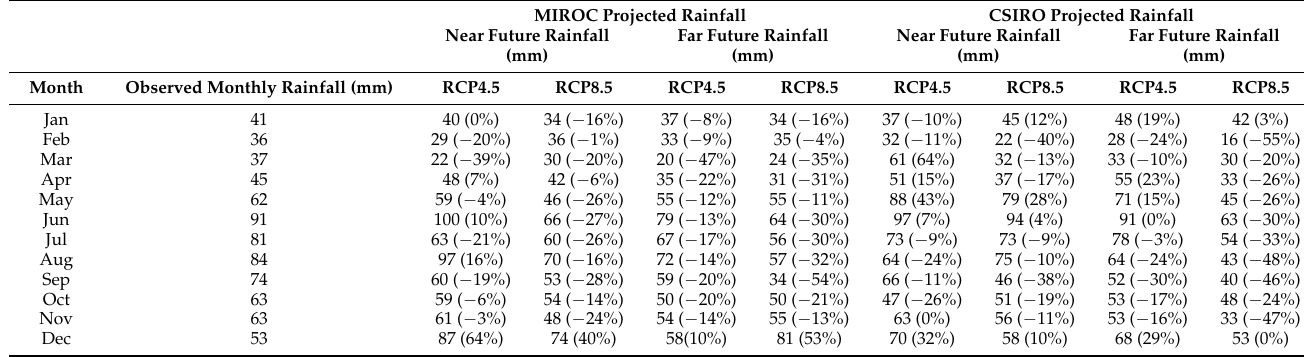
Table 2. Observed and projected monthly total rainfall (mm).